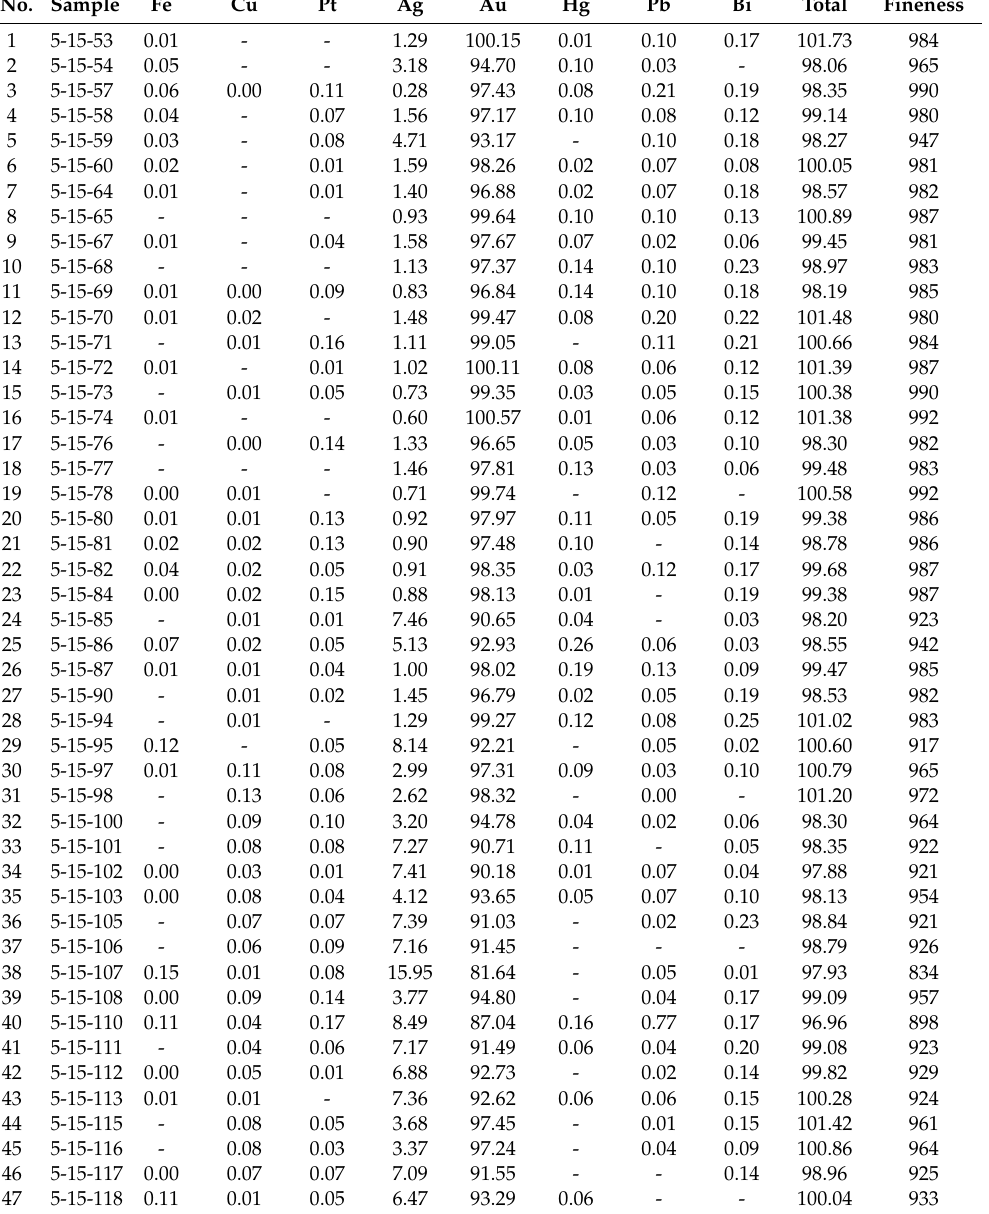
Table 4. The composition (in wt%) and fineness (in % (cid:24) ) of the massive gold (in wt%) shown in Figure 11. No.